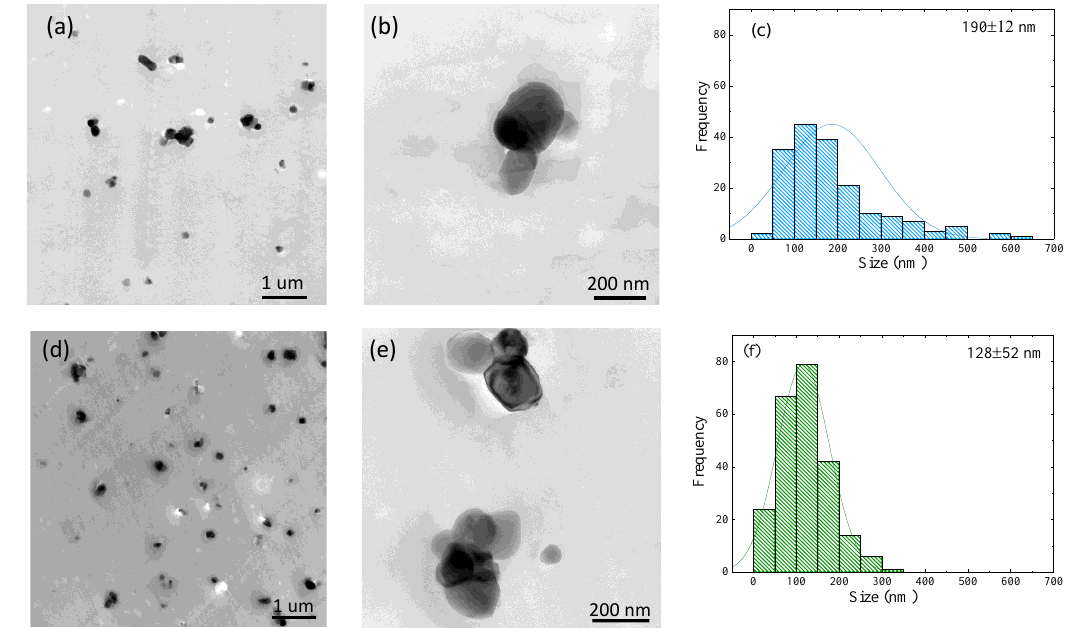
Figure 2. TEM images of r-PET ( a , b ) and REX-r-PET ( d , e ) samples and corresponding TiO 2 sizes of particle distributed in the PET matrix for r-PET ( c ) and REX-r-PET ( f ). N > 200 particles.